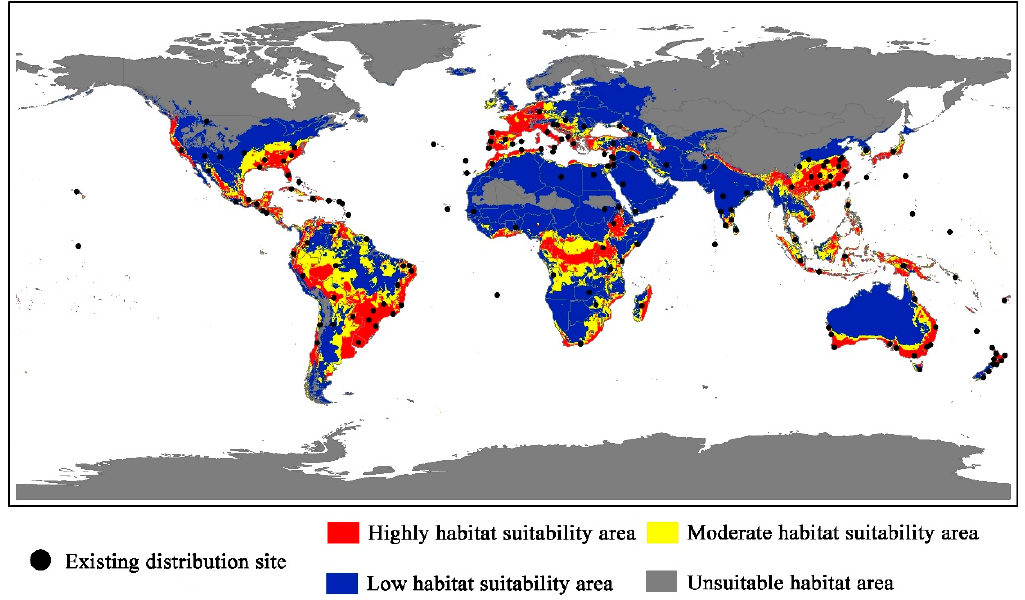
Figure 7. Potential geographical distribution of Icerya purchasi on global scale in current climate modeling.